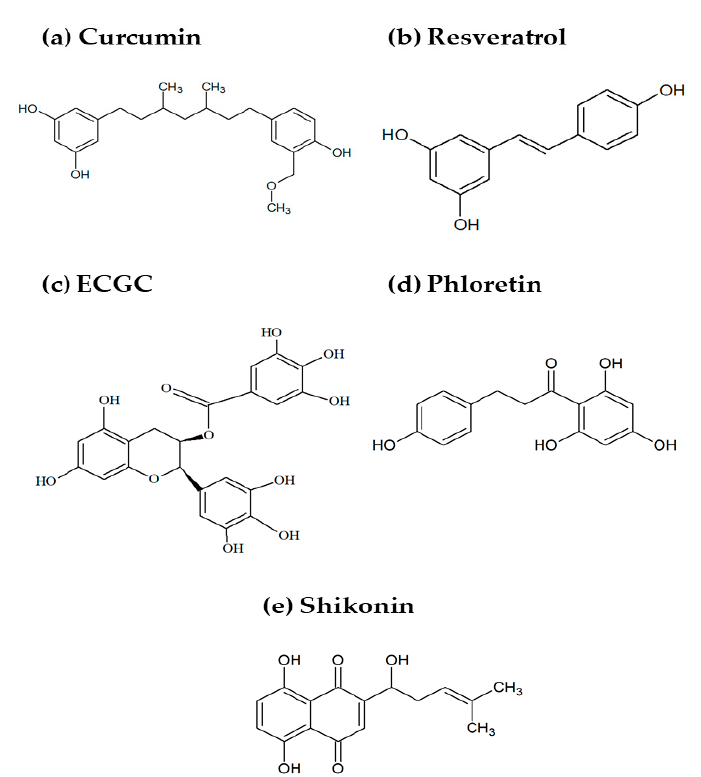
Figure 1. Chemical structures of some natural compounds reported to alter the metabolism of stromal cells in the TME: ( a ) curcumin, ( b ) resveratrol, ( c ) epigallocatechin gallate (EGCG), ( d ) phloretin, and ( e ) shikonin.